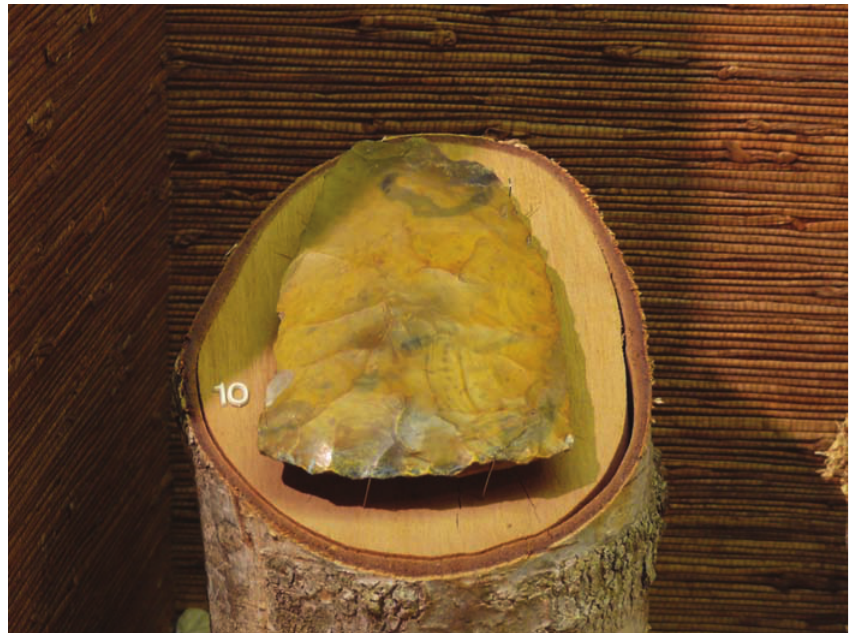
Figure 6 Mousterian (MTA) biface from crest of Wood Hills, 1km to the east of